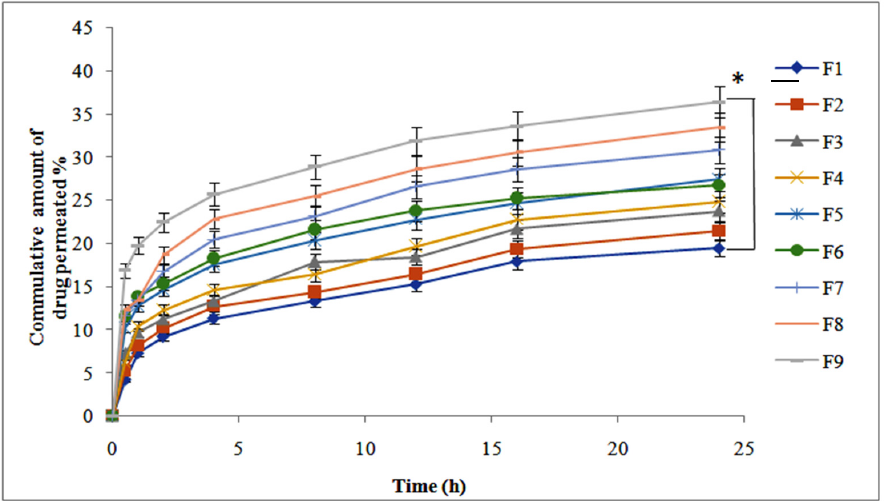
Figure 4. Permeation profiles of methotrexate from formulated patches (F1–F9). Data are expressed as mean ± SD; n = 3. One-way ANOVA followed by post hoc Tukey test ( p < 0.05), F9 vs. F1.